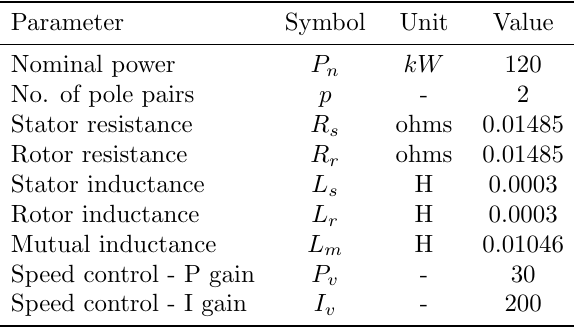
Table 6: General electric drive parameters